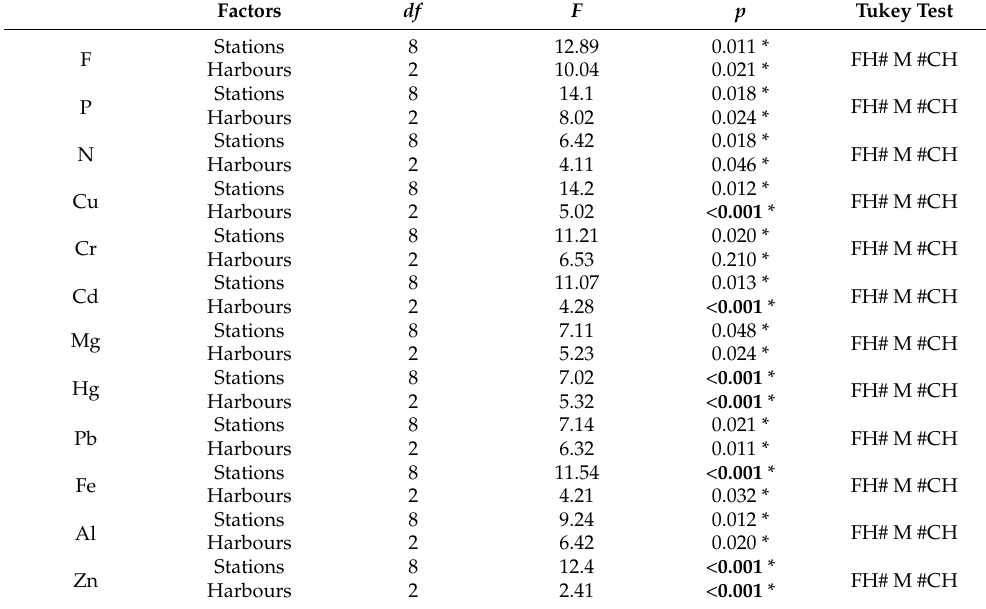
Table A1. Results of one-way ANOVAs with stations and harbours as factors for the 12 heavy metals